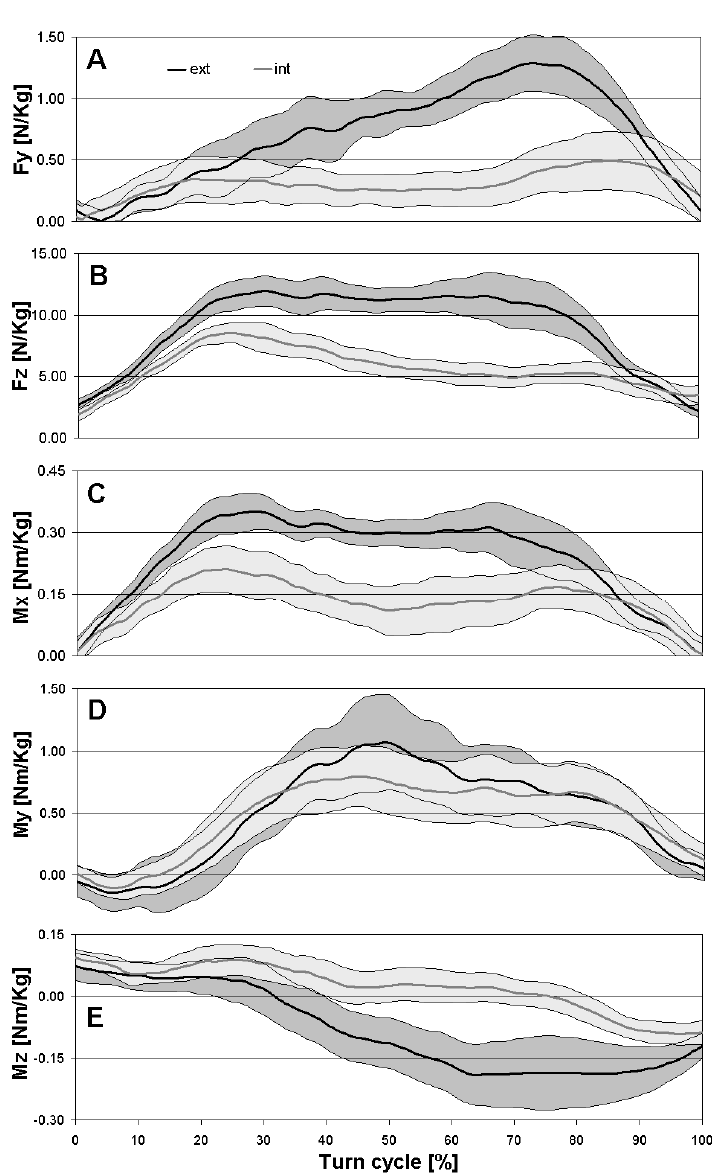
Figure 6. Mean Fy ( A ), Fz ( B ), Mx ( C ), My ( D ), and Mz ( E ) of three skiers and two runs for both skis during a turn cycle, with the 95% limit of agreement (grey area).